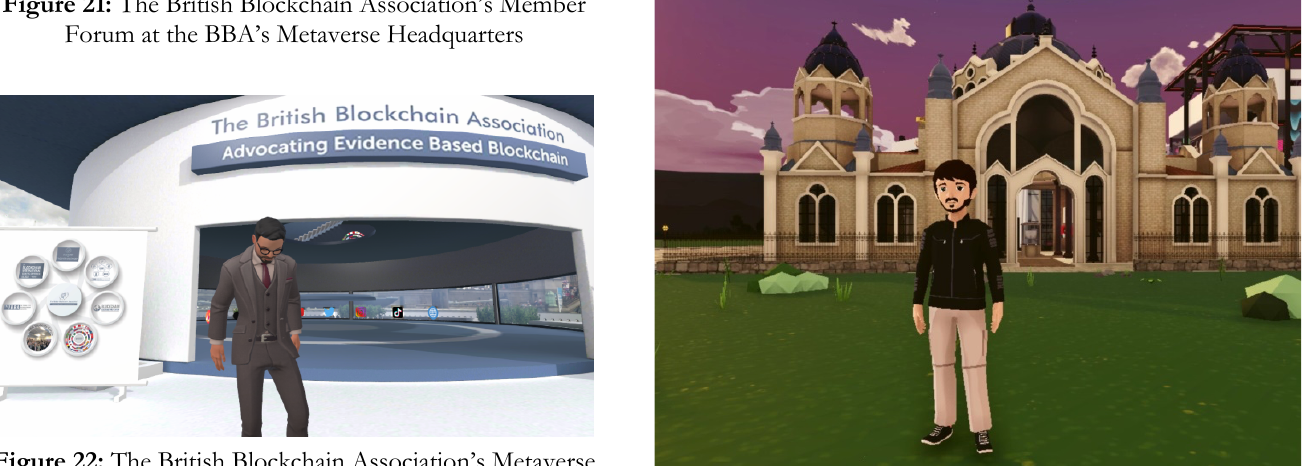
Figure 22: The British Blockchain Association’s Metaverse Headquarters in Spatial: https://bit.ly/3Ya1kSS